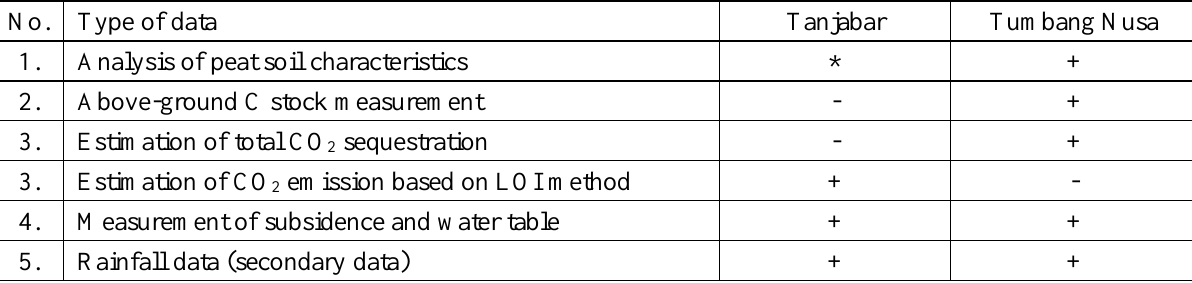
Table 1. Summary of datasets collected across the two study sites of Tanjabar (Jambi) and Tumbang Nusa (Central Kalimantan). * indicates data published in Tata et al. (2016) and not reported here; + indicates data collected; - indicates data not